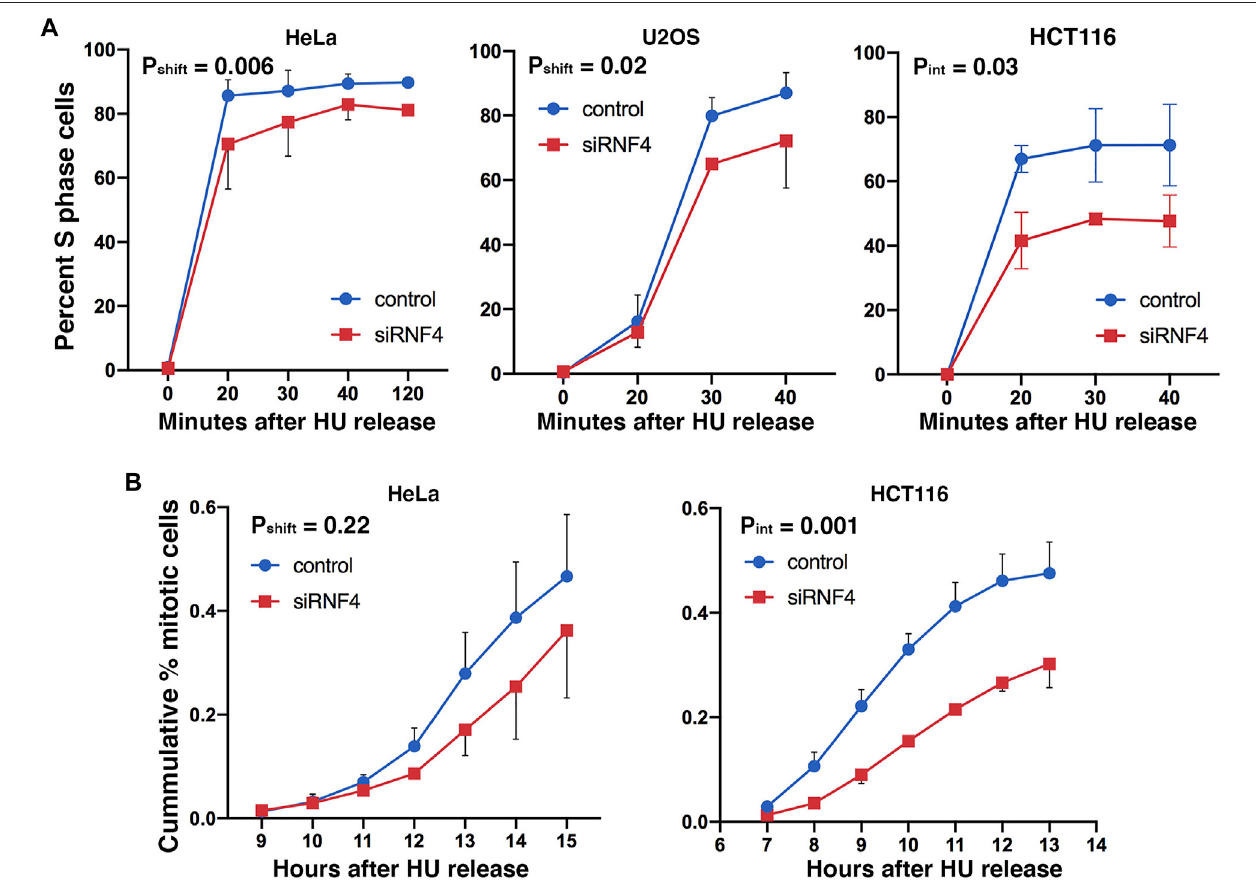
FIGURE3| RNF4depletionwasassociatedwithadelayincellcycleprogressionafterreplicationstress. (A) GraphsofpercentofSphasecellsdeterminedbyBrdU incorporation and fl owcytometricanalysis.RNF4- andcontrol-depletedHeLa,U2OS, and HCT 116cellswerecultured in 2 mM HUfor16 hand subsequently released intonormal medium andlabeled with20 μ MBrdUfor20 minatdifferenttimesafter releasefromtheHUblock.Resultsofthreeindependentexperimentswereaveraged and standard deviations shown. Because error bar overlaps made the graphs dif fi cult to view for some points, we have only shown the error bars in opposing directions. (B) GraphsofthecumulativepercentofcellsenteringmitosisafterreleasefromHUblock.RNF4-andcontrol-depletedHeLaandHCT116cellswerecultured in 2 mM HU for 16 h and then released into normal medium. Cells entering mitosis were scored by DAPI staining. Results of three independent experiments were averaged and standard deviations shown. Because error bar overlaps made the graphs dif fi cult to view for some points, we have only shown the error bars in opposing